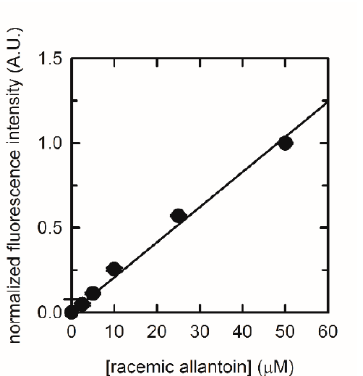
Figure 5. Normalized fluorescence emission at 530 nm ( λ ex = 490 nm) detected by microplate reader at increasing concentrations of allantoin in 100 mM phosphate buffer, pH 7.4, enzymatically processed by encapsulated puuE. Linear regression gave a R 2 of 0.99.